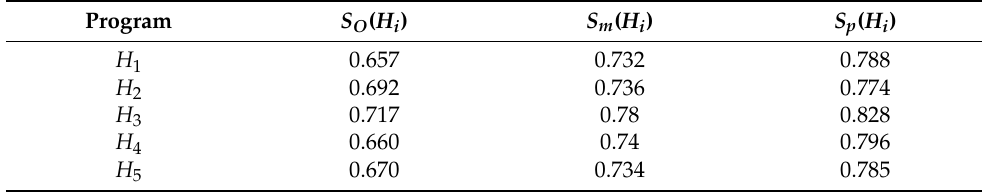
Table 2. Similarity of S O ( H i ) , S m ( H i ) , and S p ( H i ) .